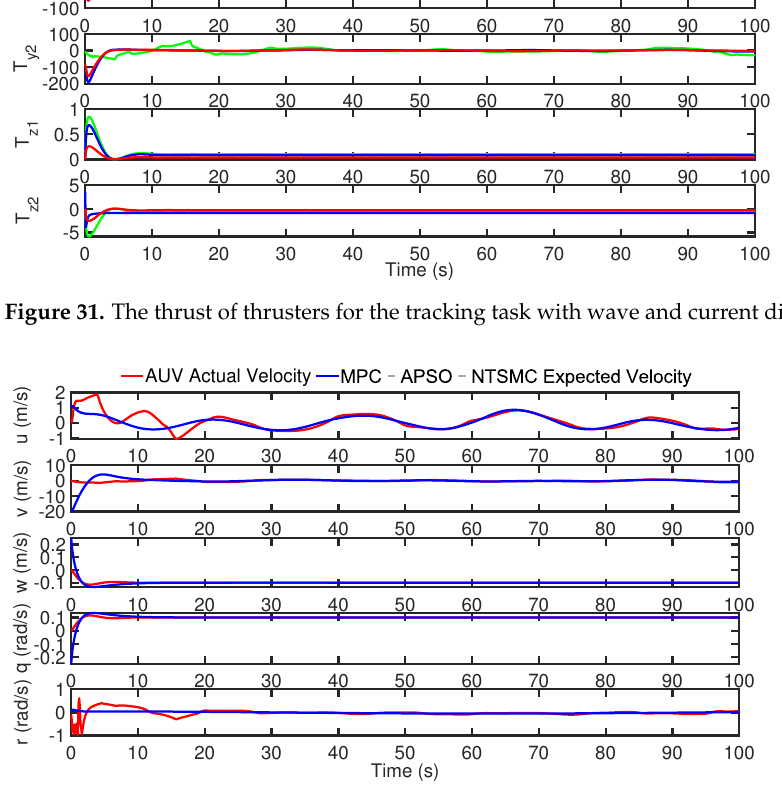
Figure 32. Velocity tracking for the AUV with wave and current disturbance for Case 2. Table 8. Position MAE with wave and current disturbance after 20 s for Case